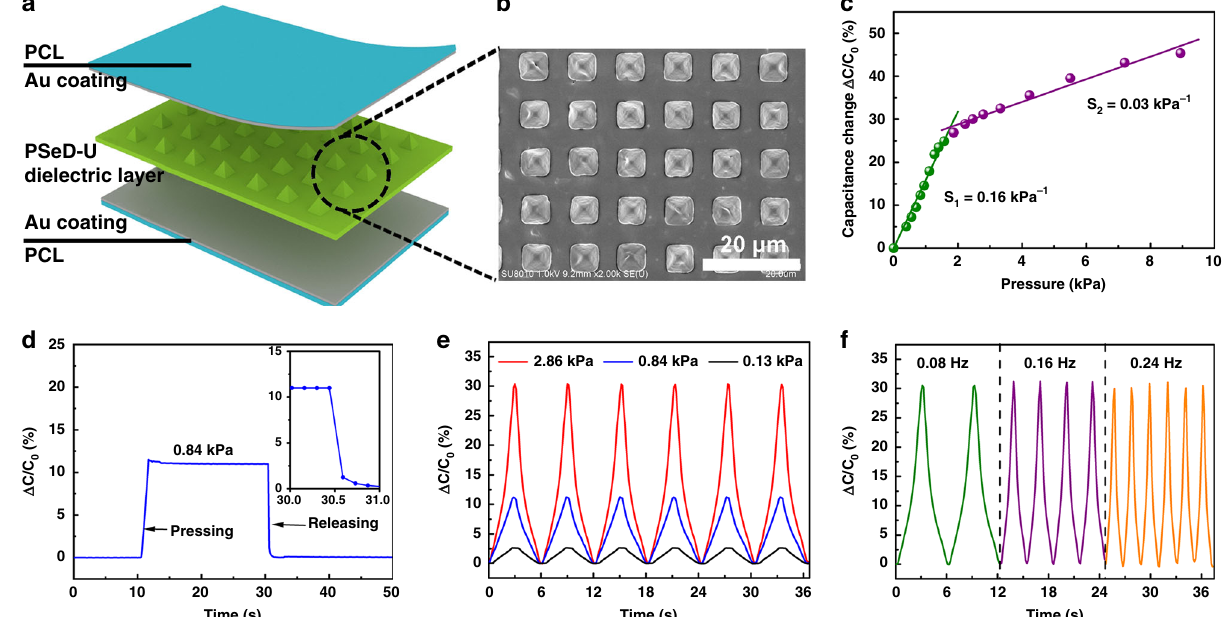
Fig. 4 Schematic and characterization of PSeD-U elastomers based piezocapacitive pressure sensor. a Schematic of the structure of the piezocapacitive pressure sensor. b SEM images of the microstructured PSeD-U20-12h elastomer dielectric fi lm. c Pressure – response curve of the piezocapacitive pressure sensor. d Response times of the pressure sensor with the pressure of 0.84 kPa. The inset shows the response time of the pressure sensor to pressure release. e Dynamic responses of the pressure sensor at various pressures with a frequency of 0.08 Hz. f Dynamic responses of the pressure sensor at various frequencies with a pressure of 2.86